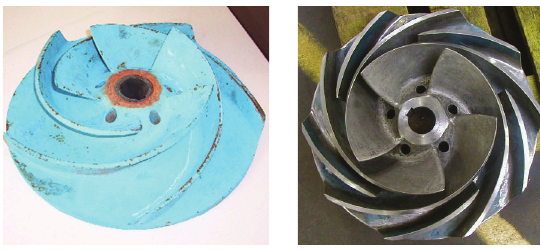
Figure 1: Original (left) and splittered (right) impellers.